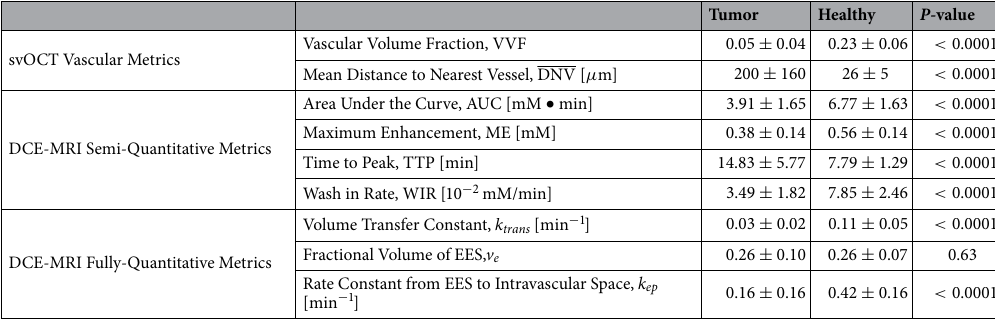
Table 1. Healthy vs. tumor tissue quantification by svOCT and DCE-MRI.